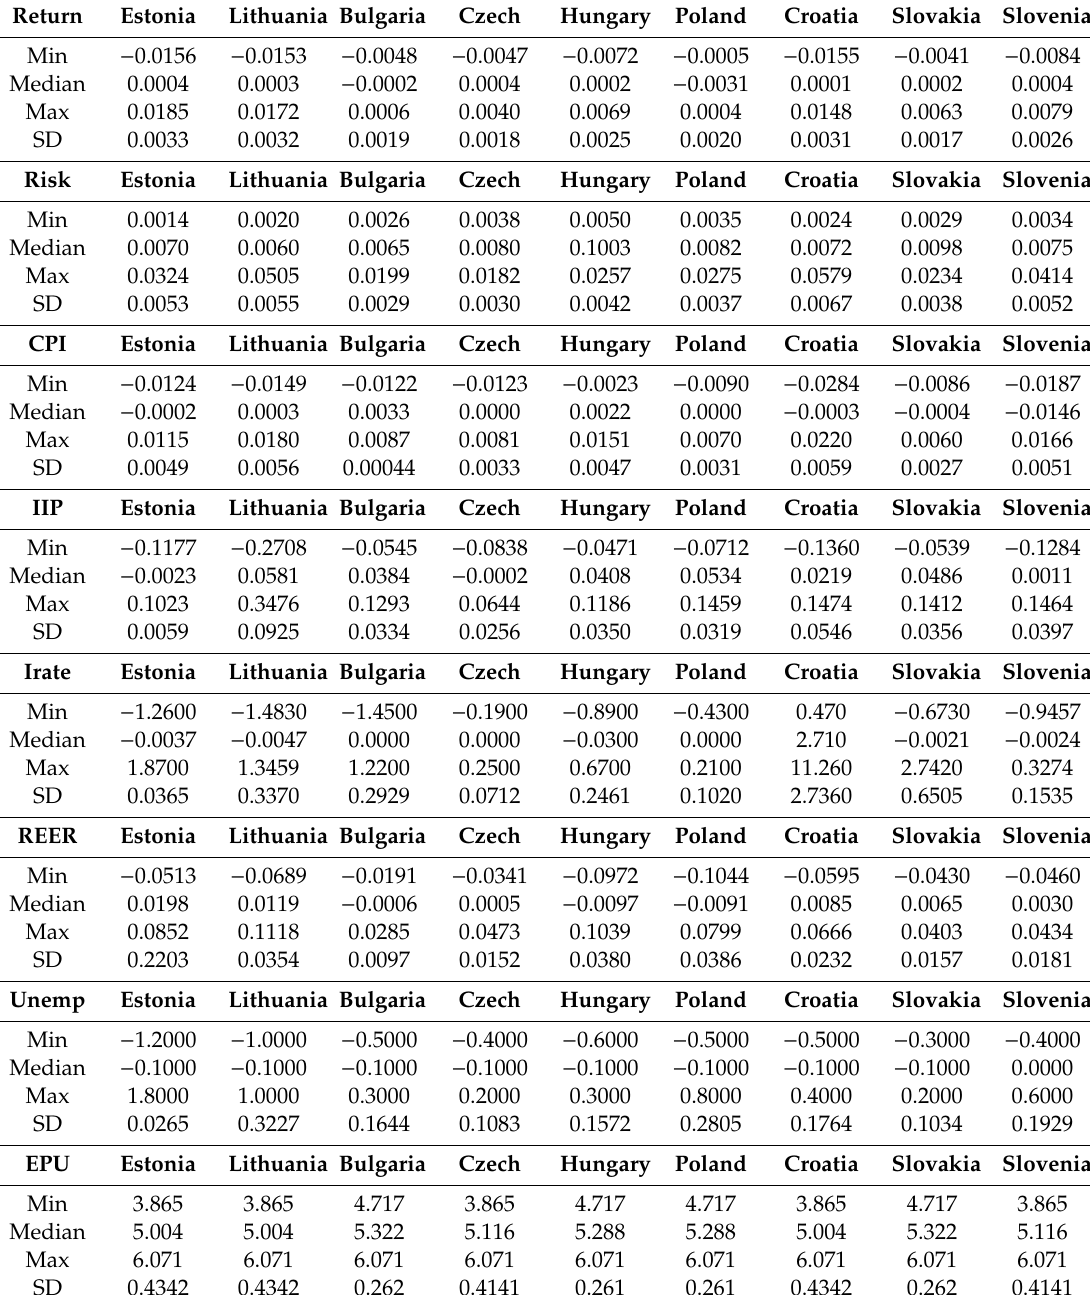
Table A3. Descriptive statistics for stationary variables for every